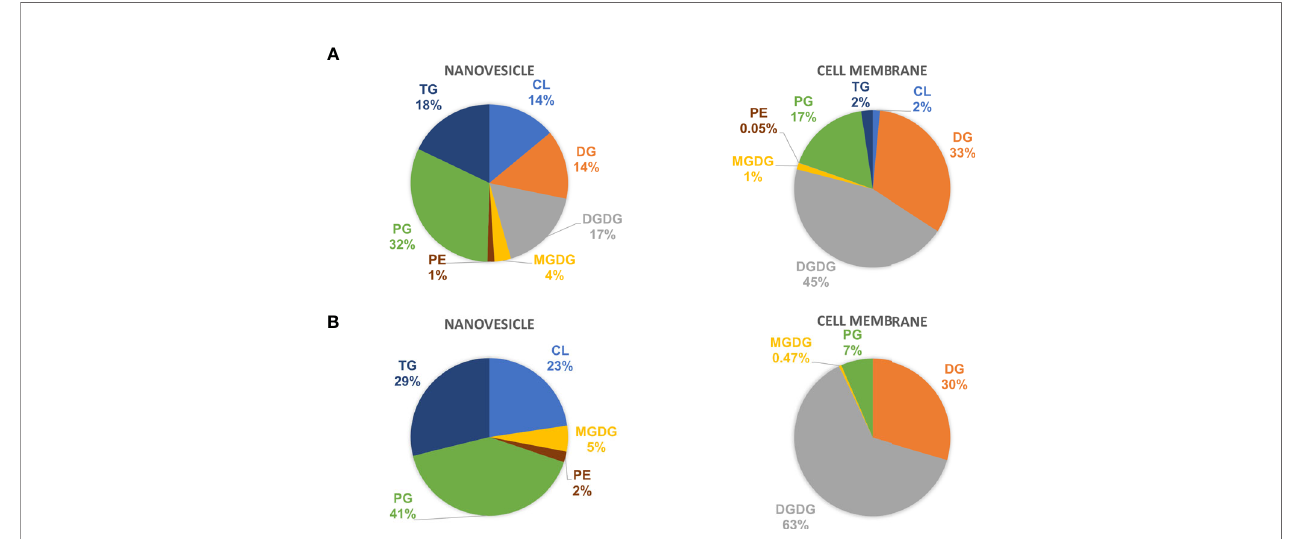
FIGURE 2 | The lipid pro fi les of NV and CM from L. johnsonii N6.2. (A) The total lipid composition of NV (left) and CM (right) represented as percentages. (B) The enriched lipids found in the NV and CM represented as percentages. PE, glycerophosphoethanolamines; PG, glycerophosphoglycerols; TG, triradylglycerolipids; CL, cardiolipins; MGDG, monogalactosyldiacylglycerol; DGDG, digalactosyldiacylglycerol; DG, diradylglycerolipids.